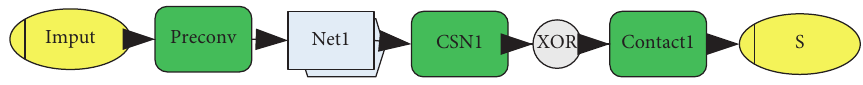
Figure 3: DMCNN algorithm